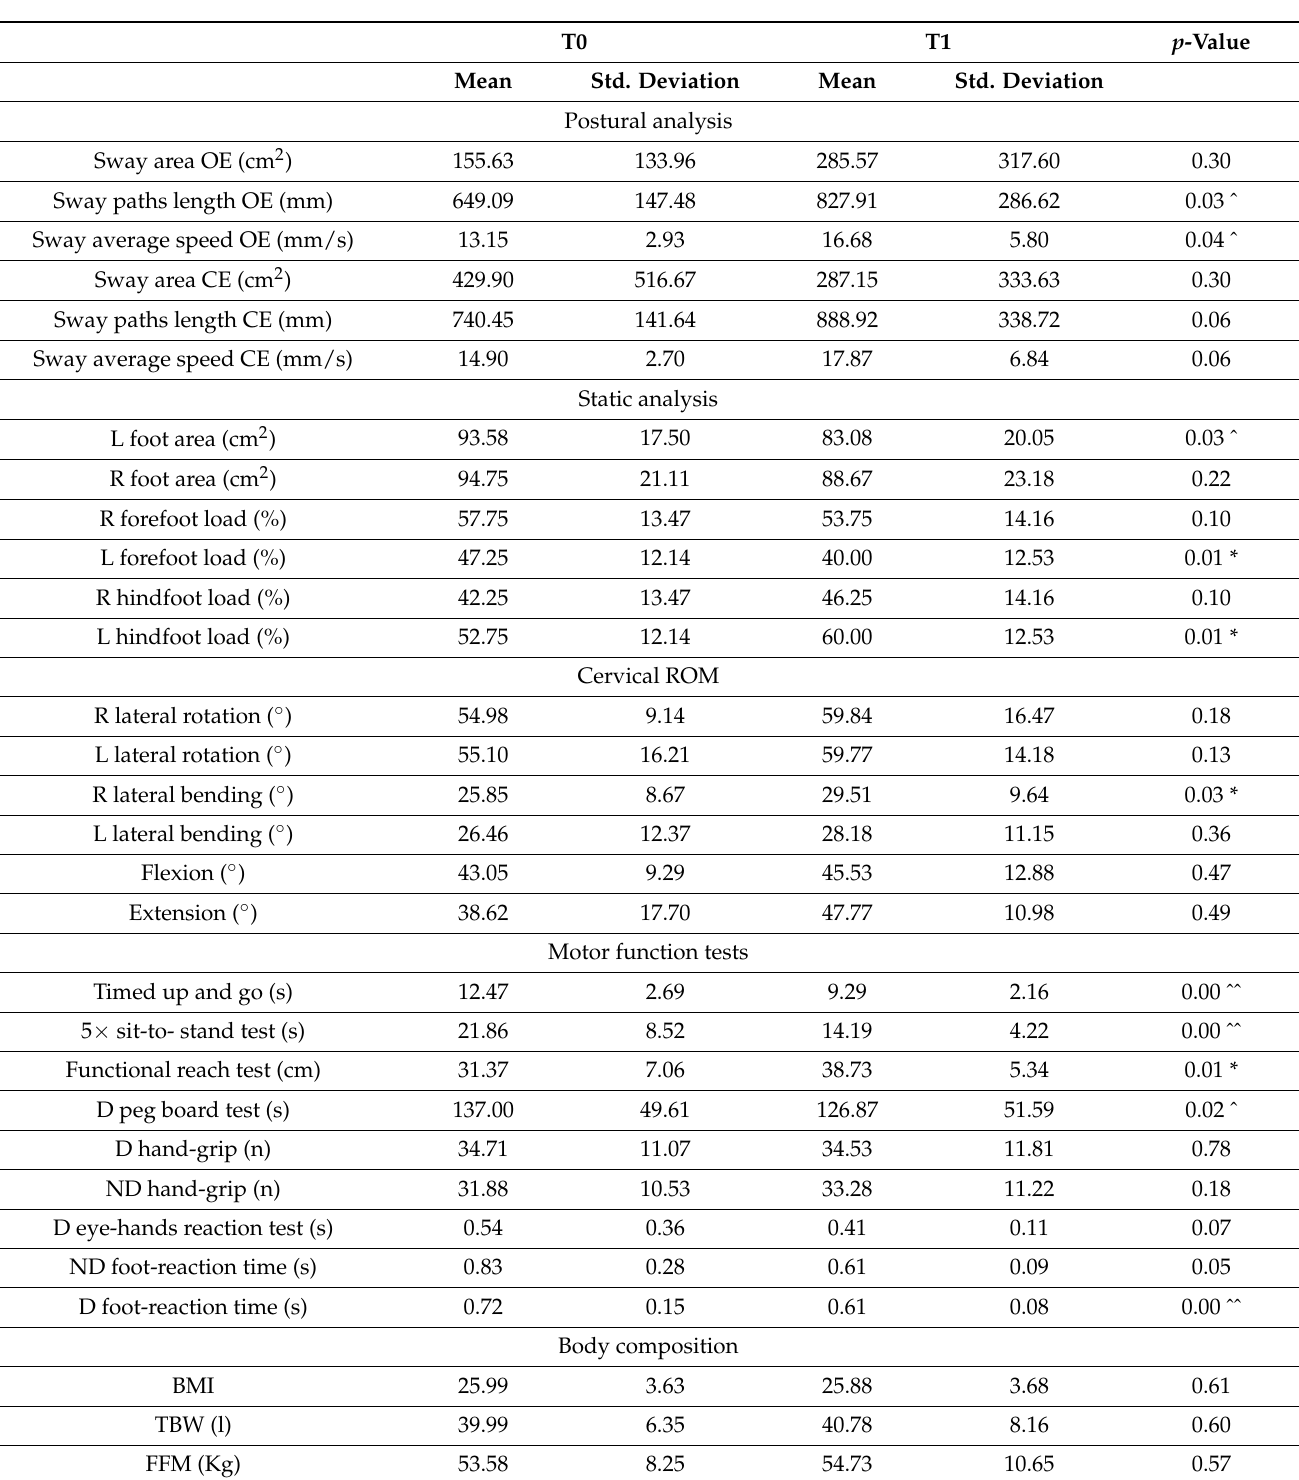
Table 3. Motor performance and body composition variables at baseline (T0) and after 11 weeks (T1). Data from motor performance and body composition were collected at time 0 (baseline) and at the end of the 11 weeks. T0 T1 p -Value Mean Std. Deviation Mean Std.